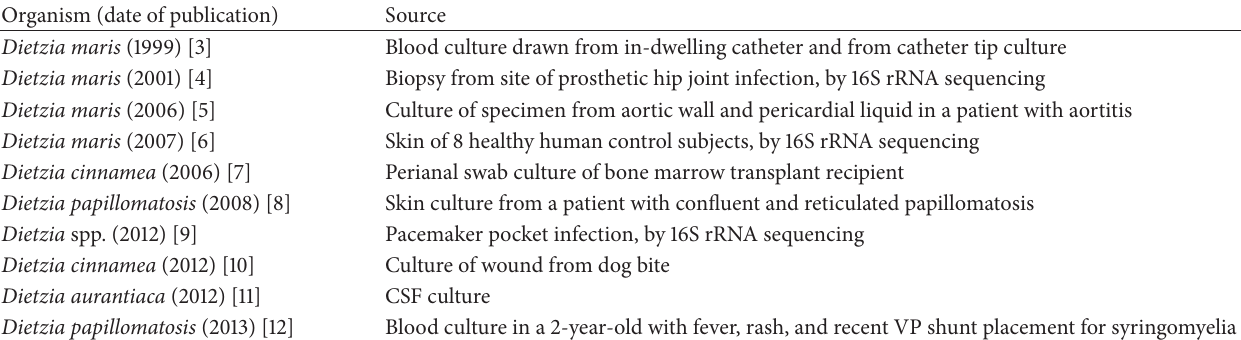
Table 1: A PubMed search performed in June 2016 using the terms “Dietzia”, “Dietzia and infection” revealed the following published case reports identifying Dietzia spp. from human clinical specimens. This excludes the 24 isolates which retrospectively reclassified organisms initially identified as Rhodococcus